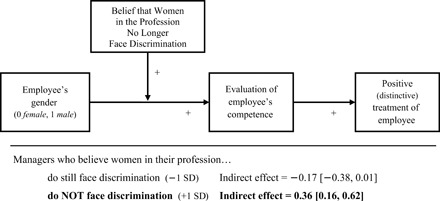
Managers’ differential treatment of the target employee, as a function of the employee’s purported gender and managers’ (biased) evaluations of the employee’s competence (rooted in their belief that women in the profession no longer face discrimination) (n = 222).Managers’ competence evaluations were key to predicting how they would treat the employee {e.g., willingness to let her/him take on more supervisory responsibilities and be more involved in managing the business/financial side of the practice (if s/he was in their practice); B = 0.77 [0.56, 0.98], SE = 0.11, P < 0.001}. However, these competence evaluations were themselves systematically biased among those who thought gender bias was no longer an issue (condition*bias-belief, B = 0.22 [0.11, 0.33], SE = 0.06, P < 0.001), which translated into differential, discriminatory treatment. In other words, there was a significant indirect effect of target gender on treatment but only among those who believed that gender bias was no longer an issue: indirect effect = 0.36 [0.16, 0.62]. Among managers who rejected this belief, the employee’s gender had no bearing on how s/he would be treated (indirect effect = −0.17 [−0.38, 0.01]).